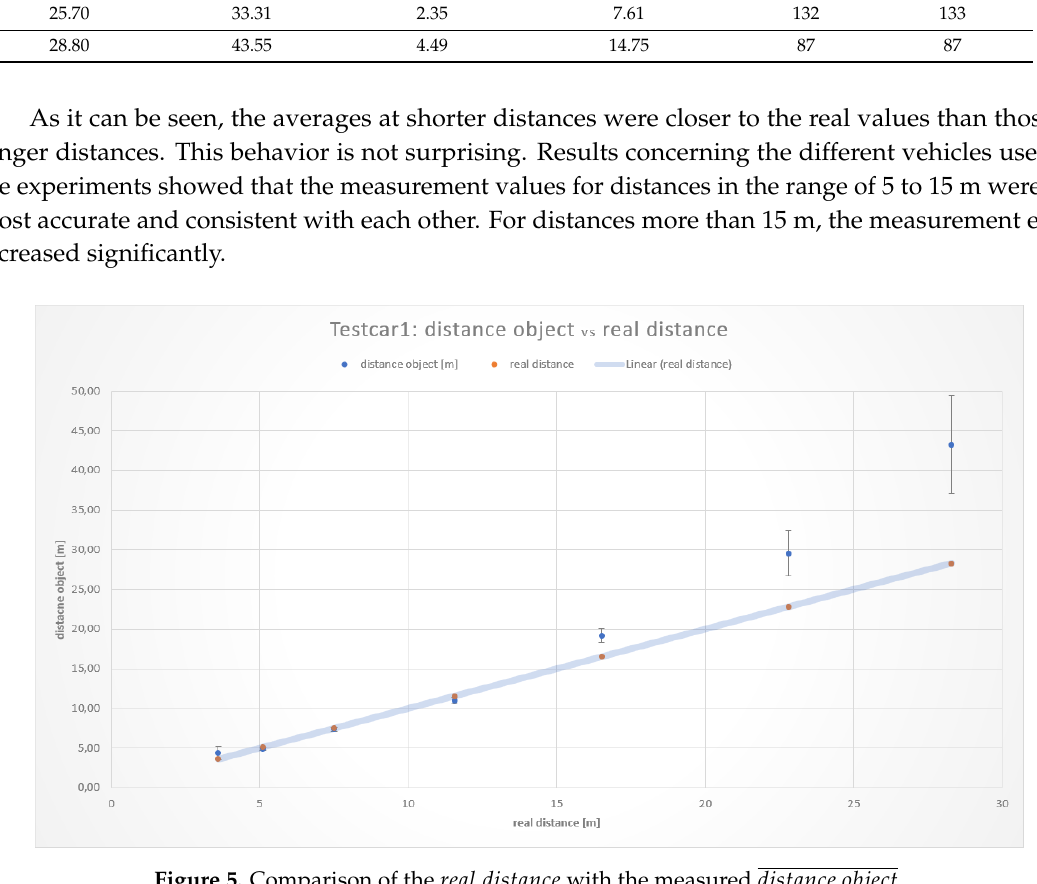
Figure 5. Comparison of the real distance with the measured distance object